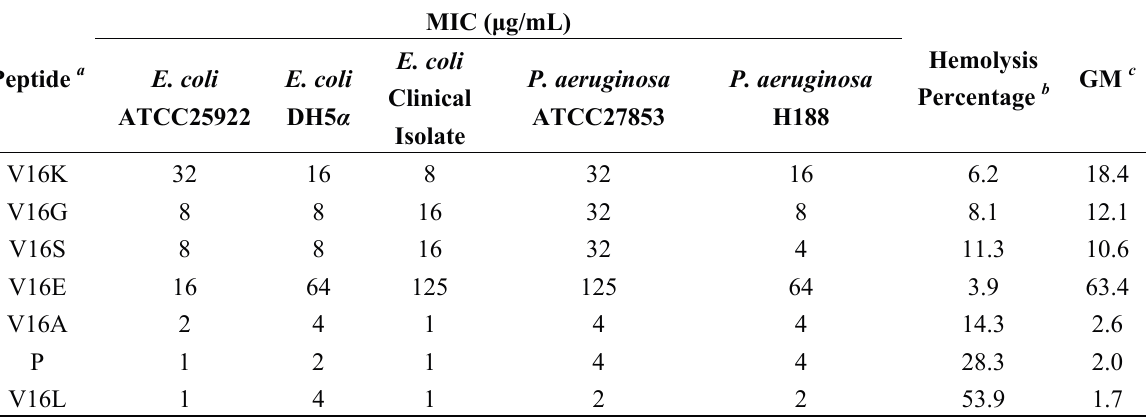
Table 3. Minimal inhibitory concentration (MIC) of peptides against Gram-negative bacteria and hemolysis percentage against human red blood